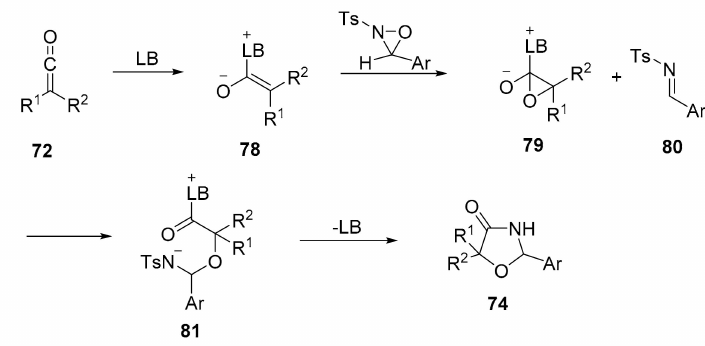
Scheme 21. Mechanistic proposal for Lewis base-catalyzed